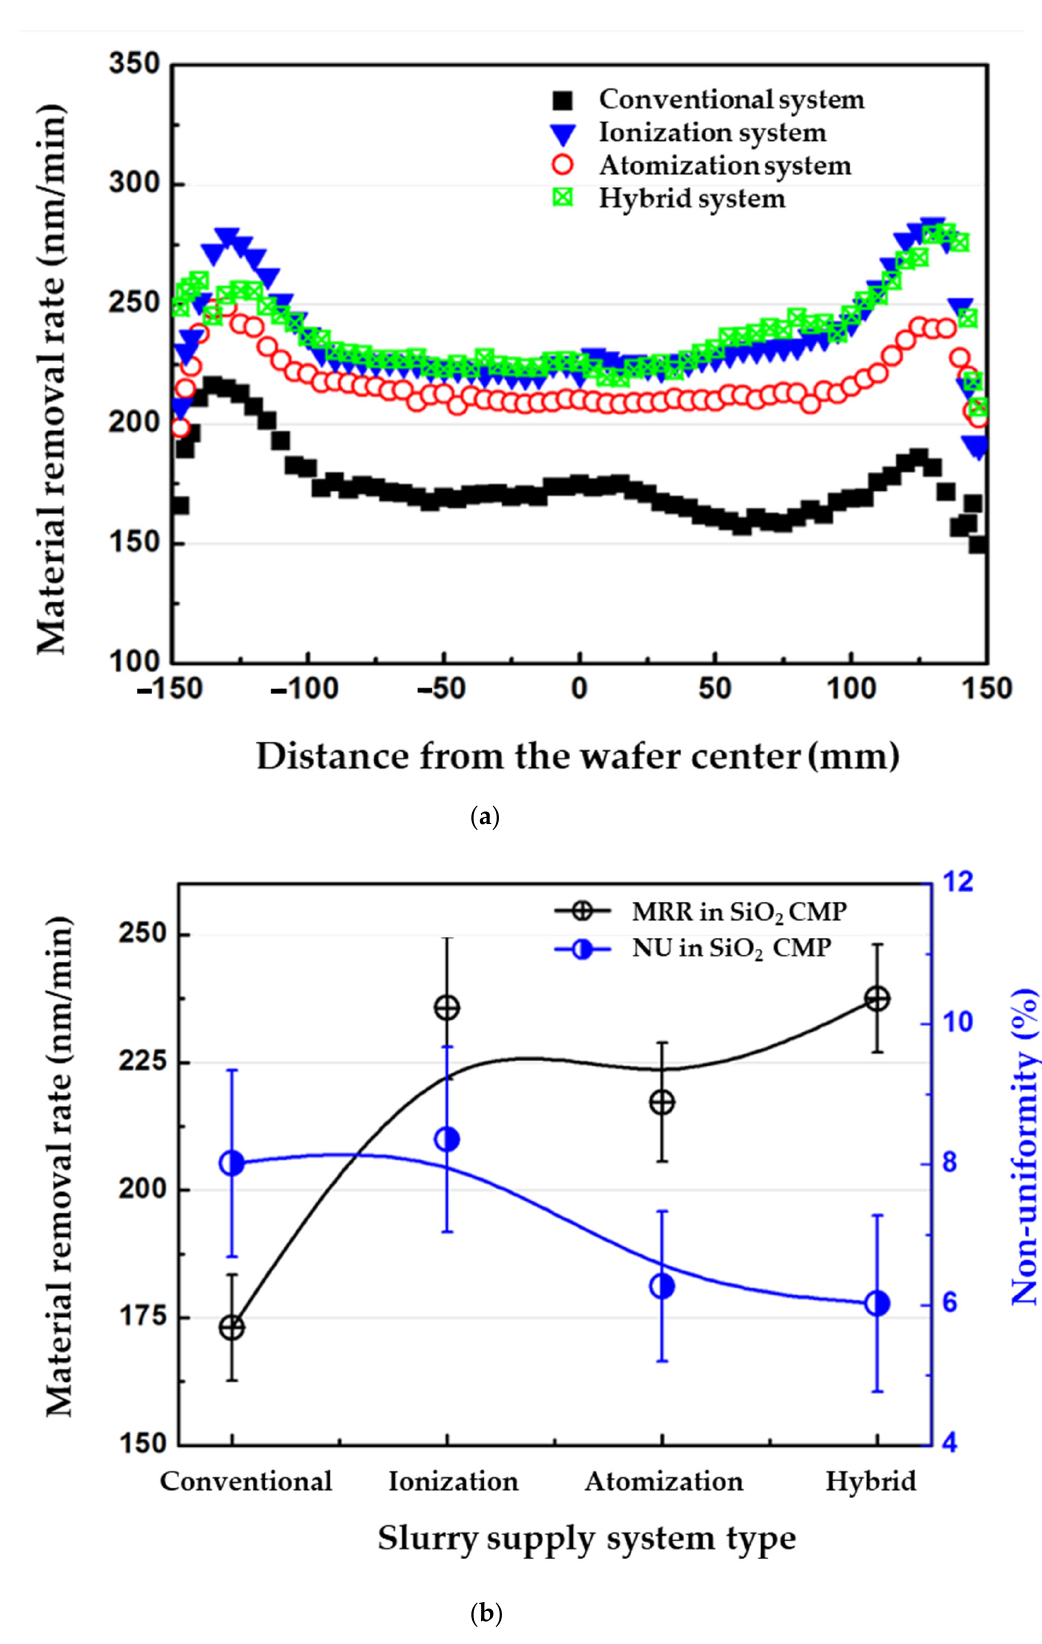
Figure 6. 300-mm SiO 2 NPW CMP results based on the types of slurry supply systems. ( a ) MRR profiles and ( b ) average MRR and NU.